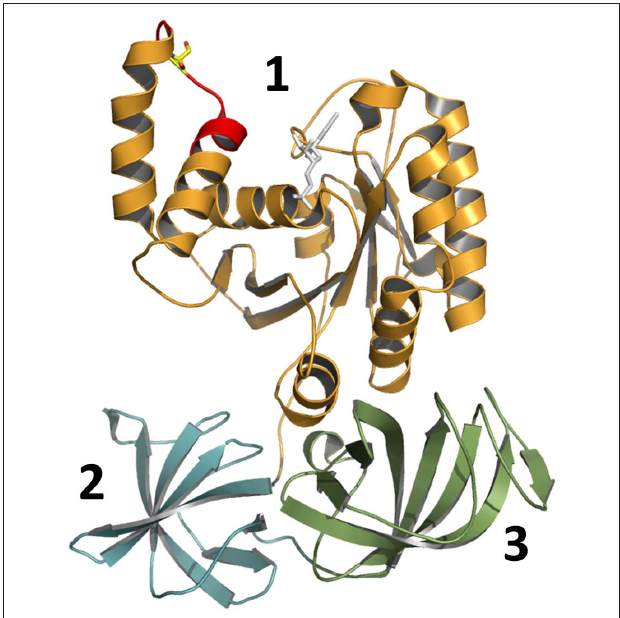
FigurE 2 | Structural view of yeast elongation factor eEF1A (adapted from pdb 1iJF). Elongation factor eEF1A consists of three main structural parts: domain 1 (G-domain), domain 2, and domain 3 (indicated by numbers). The decapeptide (GKGSFKYAWV), which is a sufficient substrate for glucosylation by Lgt, is shown in red. Serine-53, which is modified by glucosyltransferases Lgt, is shown in yellow. The complexed fragment of eEF1B α molecule, which is present in the original structure,